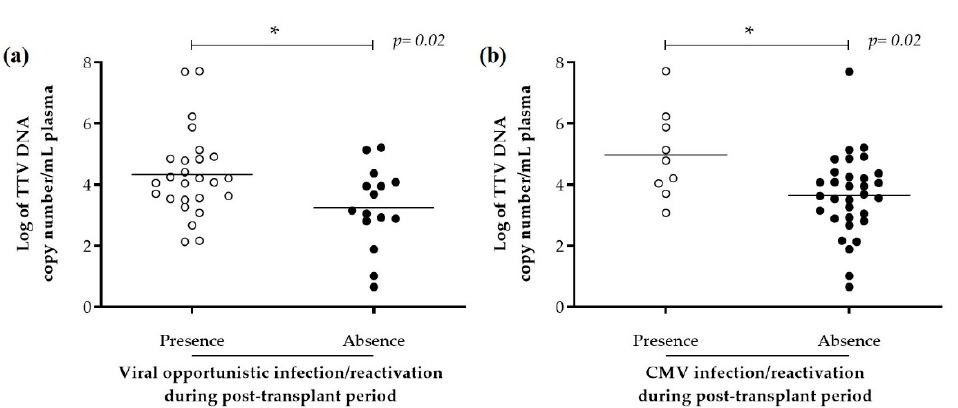
Figure 3. TTV viral load in allo-HSCT recipients according to post-transplant viral infection / reactivation. TTV viral load from 41 allo-HSCT with (white) or without (black) ( a ) viral opportunistic infection / reactivation and ( b ) CMV infection / reactivation during post-transplant period. Comparison between groups was performed using Mann–Whitney test, the asterisk (*) denotes statistical significance at p < 0.05. Abbreviations: Allo. allogeneic; CMV. Cytomegalovirus; HSCT. haematopoietic stem cells transplantation; TTV. torque teno virus.